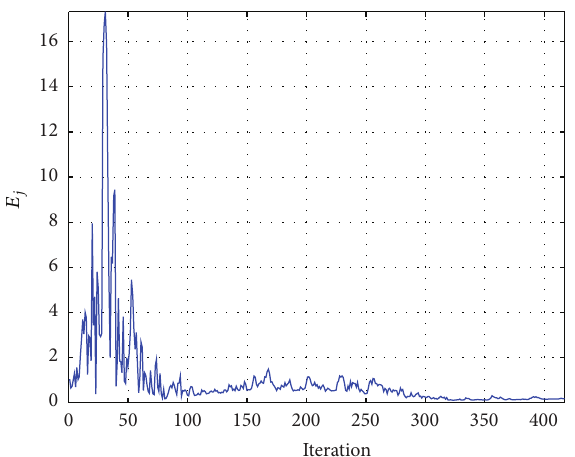
Figure 16: Tracking accuracy of AEKF for straight flight target.